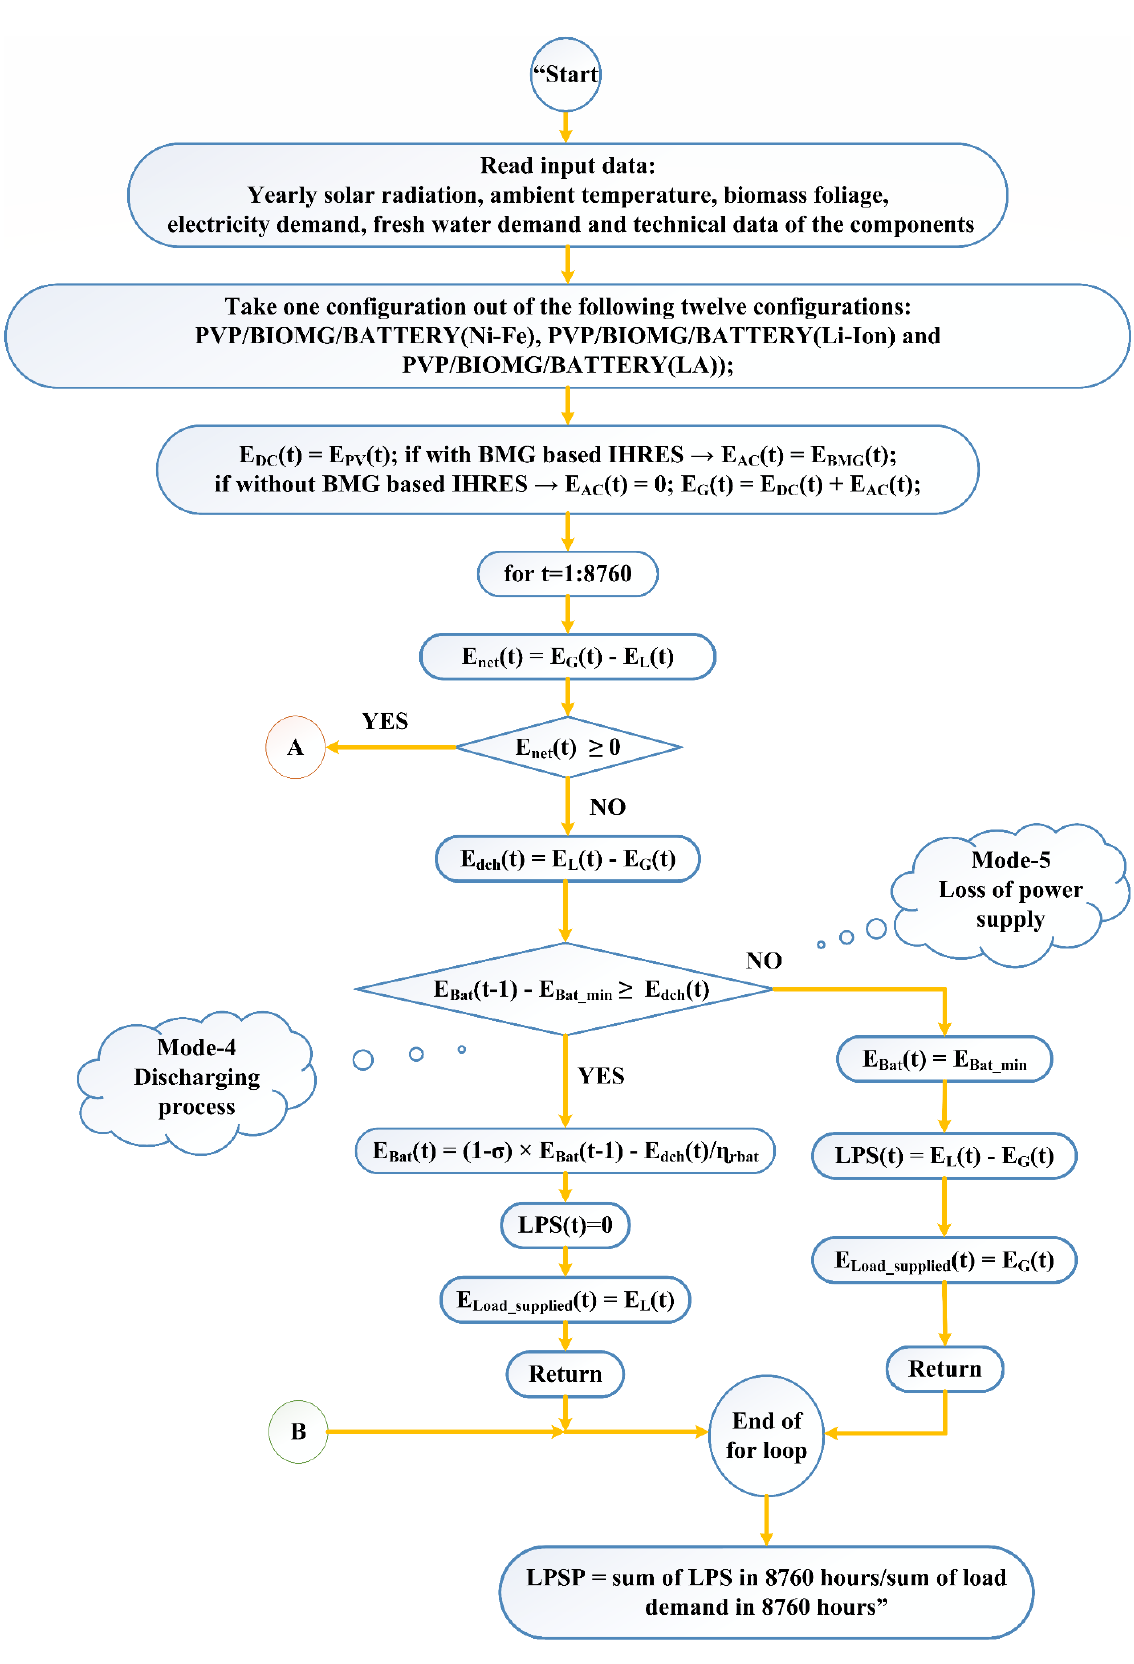
Figure 6. Modes of operation for the off-grid microgrid.